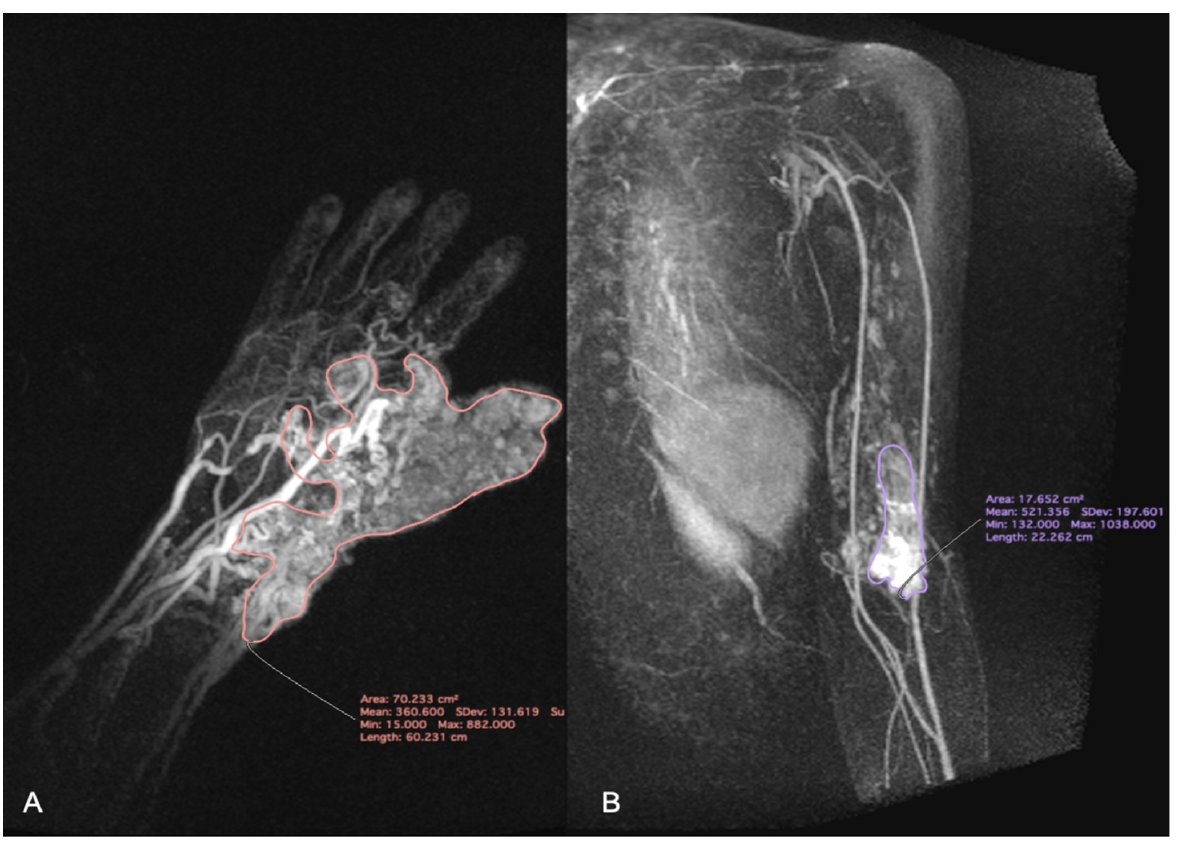
Figure 2. Time-resolved magnetic resonance angiography with interleaved stochastic trajectory (TWIST) maximum intensity projection (MIP) images. Vascular malformations (VMs) with the corresponding regions of interest (ROIs). ( A ) VM of the hand and wrist; ( B ) VM of the arm.